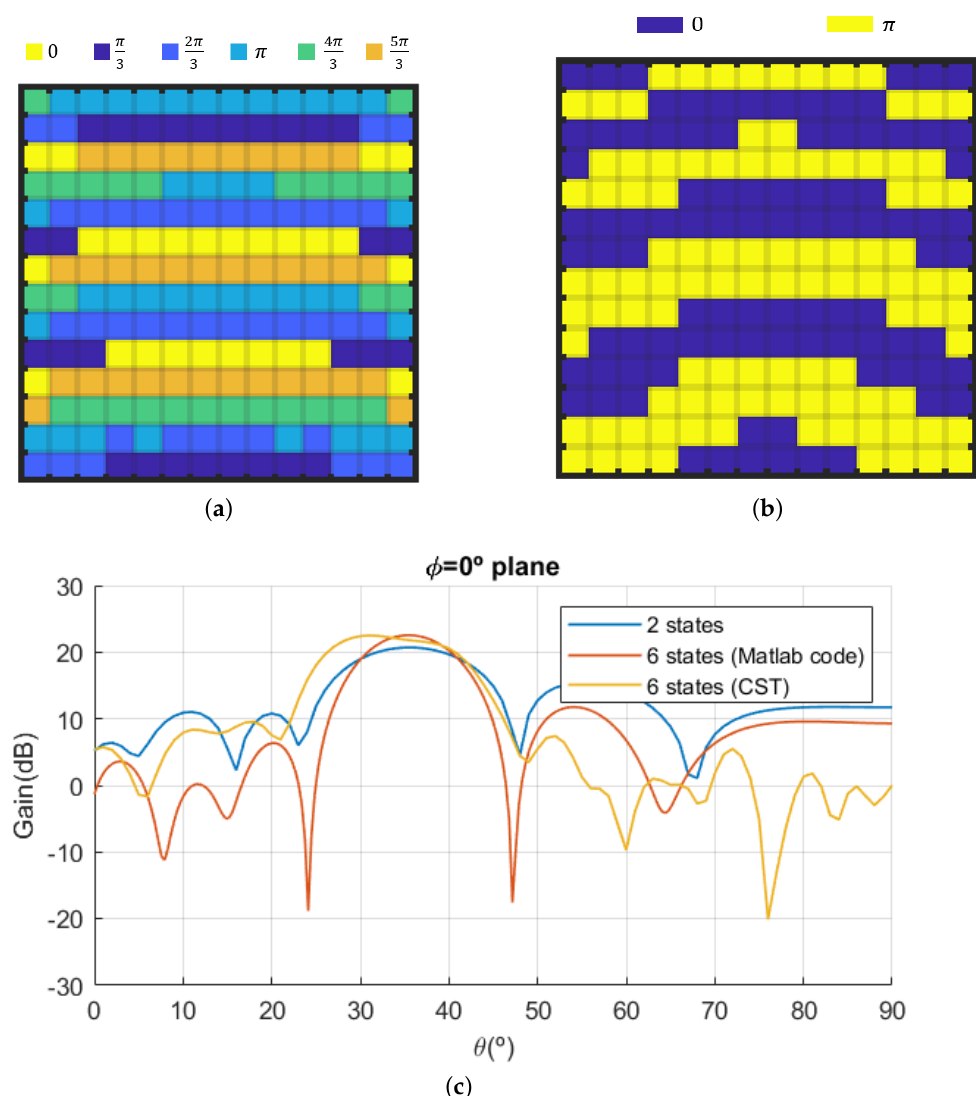
Figure 5. ( a ): Phase arrangement considering six states. ( b ): Phase arrangement considering two states. ( c ): Radiation pattern, beam direction: ( ϕ , θ ) = (0,35) ◦